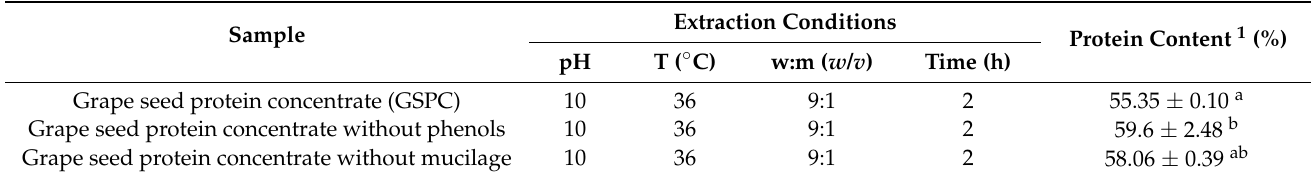
Table 5. Protein content (%) of the optimized grape seed protein concentrate (GSPC) with and without phenols and mucilage.